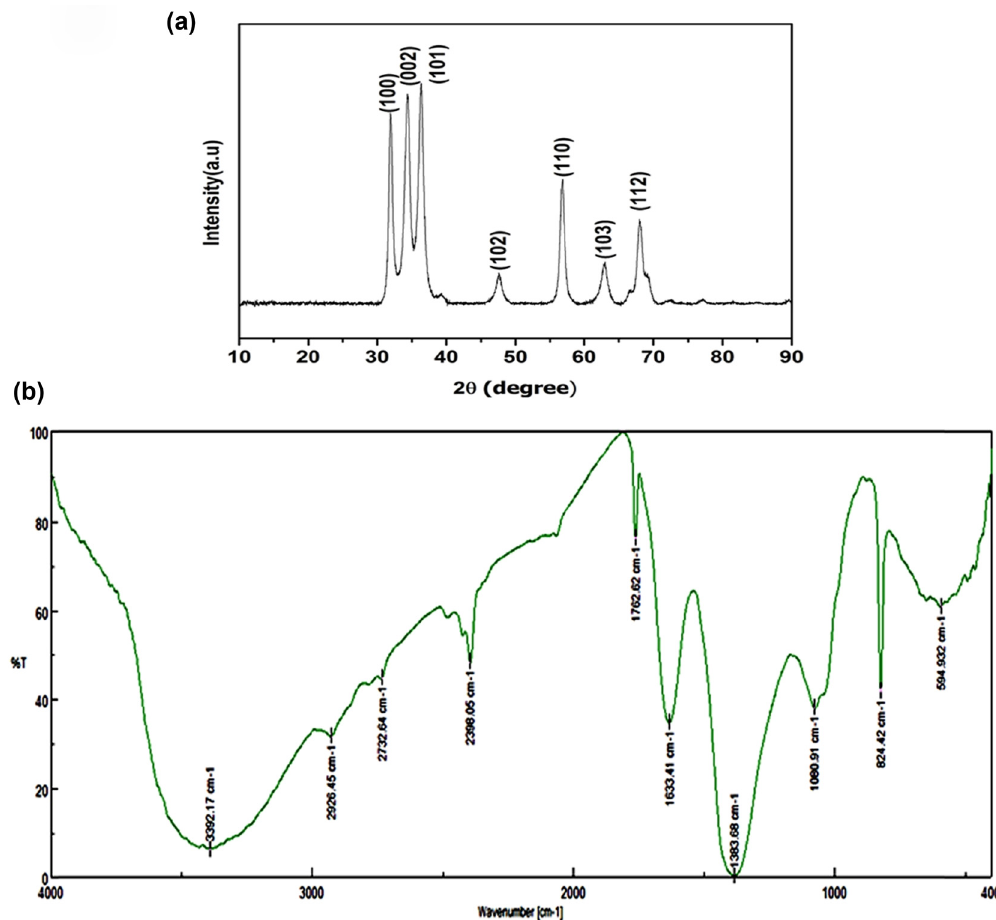
Figure 2: XRD and FTIR analyses of ZnONPs - NC: ( a ) XRD analysis of ZnONPs - NC shows the peak intensities of 100, 002, 101, 102, 110, 103, and 112; ( b ) FTIR studies con fi rm the biologically active molecules present in the ZnONPs - NC based on the peak